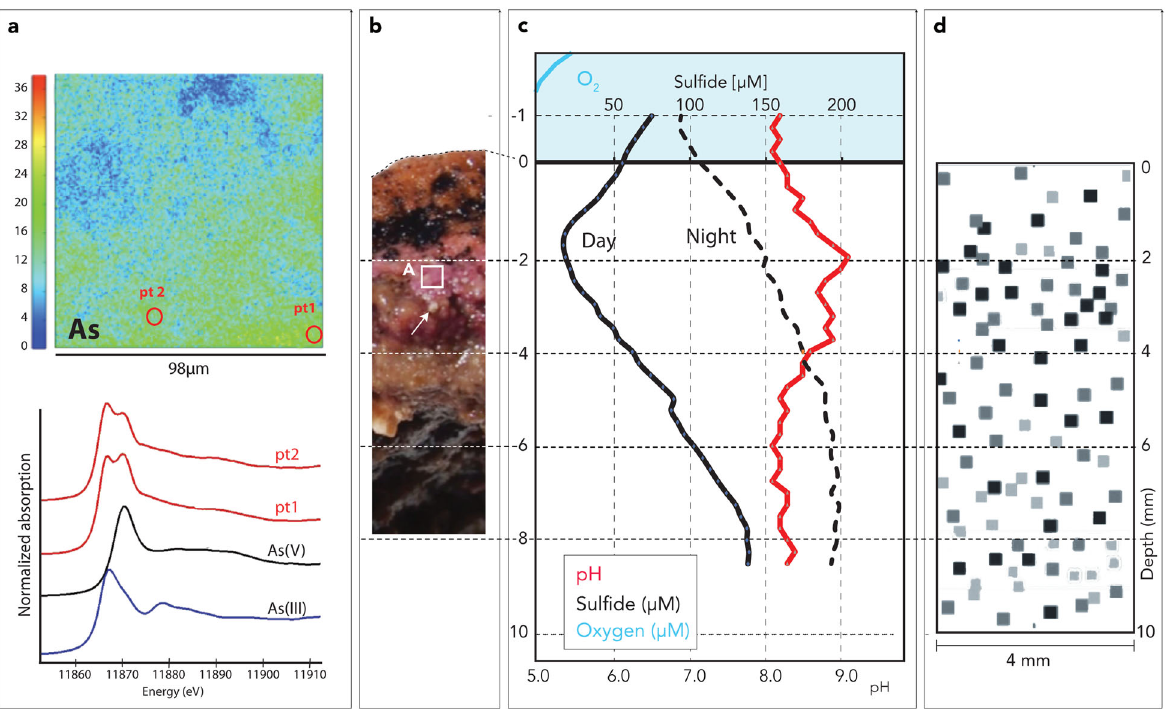
Fig. 2 Biogeochemistry of Laguna La Brava Channel mats. Geochemical and microbial metabolic observations in the channel mats; from left to right: a μ XRF (top) and μ XANES (bottom) images showing a heat map of As distribution (top) and point measurements indicating the presence of two As oxidation states (bottom; red lines depict As spectra at pt 1 and pt 2; black lines are As(III) and As(V) standards) in the surface of the mat (see white frame, b ); b Hand sample in cross section showing the different layers and mineral precipitates in pink layer; dashed line indicates mat surface. Arrow indicates precipitated carbonate mineral. White frame shows location of measurements in ( a ); c Depth pro fi les of sul fi de (black), pH (red), and oxygen (blue; minute concentration only detected near the surface of the water indicating anoxia in the mat and overlying water) solid lines represent daytime measurements, dashed lines are night-time observations; bold black horizontal line indicates mat-water interface (depth = zero mm; water depth indicated as negative integer); d 2D distribution of sulfate-reducing activity in upper 10 mm of the mat (pixels showing locations of SR; darker pixels indicate higher rates). Measurements were carried out in the Chilean summer of 2015. Please note that b – d have corresponding vertical (depth)